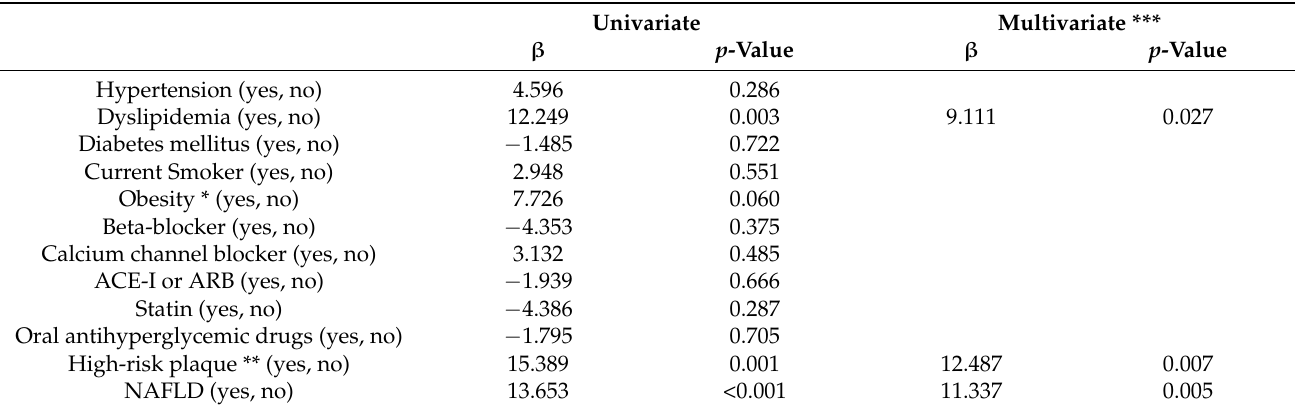
Table 2. Factors associated with